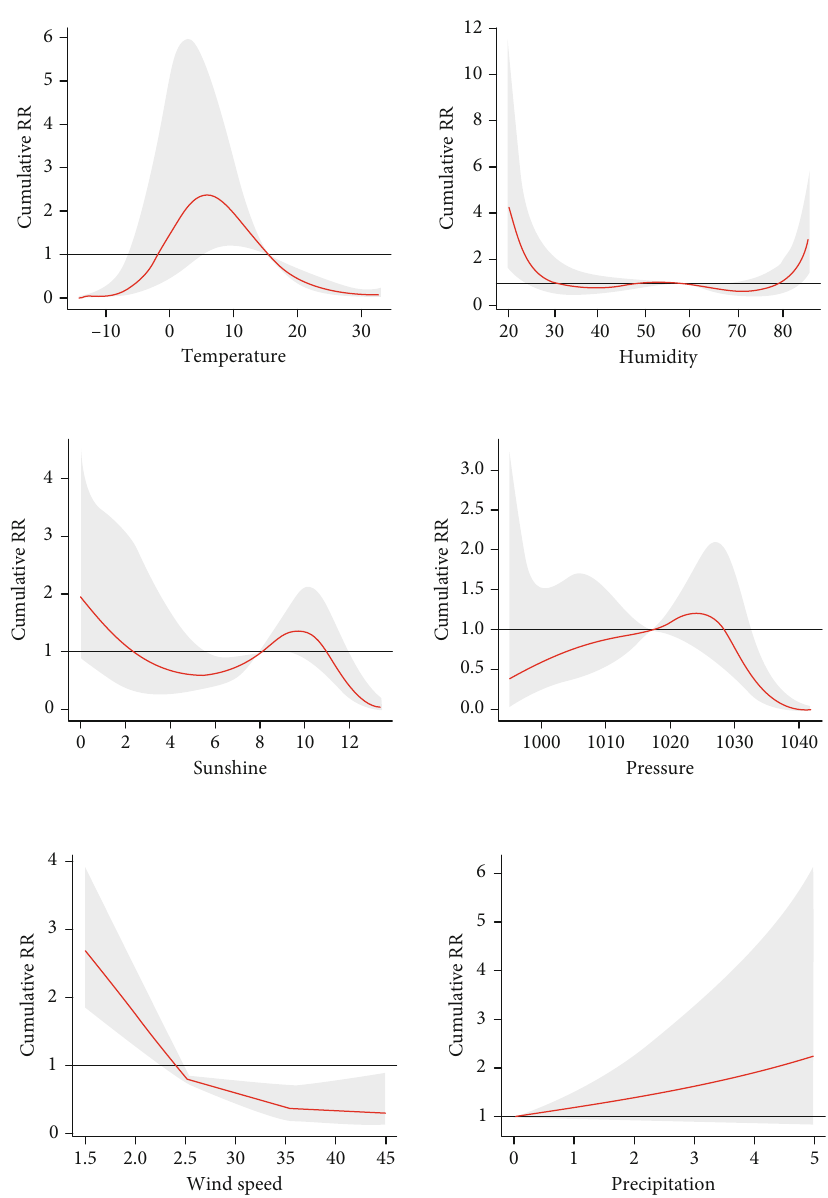
Figure 5: Cumulative e ff ect curve of di ff erent meteorological factors on the incidence of